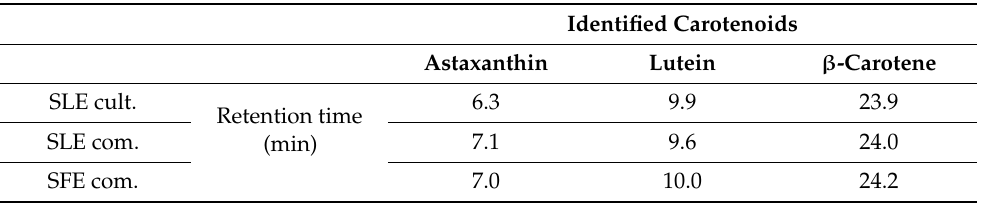
Table 3. Retention time of the selected carotenoids of the examined extracts analyzed by